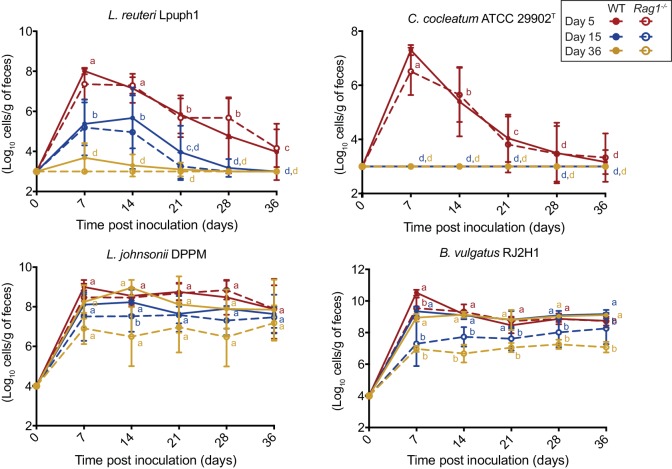
Comparison of fecal cell numbers of specific colonists in WT and Rag1-/- mice in relation to arrival timing.Absolute abundances of Lactobacillus reuteri Lpuph1, Lactobacillus johnsonii DPPM, Bacteroides vulgatus RJ2H1, and Clostridium cocleatum 29902T in fecal samples of WT and Rag1-/- mice when inoculated into mice at day 5 (n = 10 WT; n = 16 Rag1-/-), day 14 (n = 22 WT; n = 15 Rag1-/-), and day 36±2 (n = 11 WT; n = 14 Rag1-/-) after birth. Mice received complex microbiota at day 10. Mean ± standard derivation of two replicates per experiment are shown.